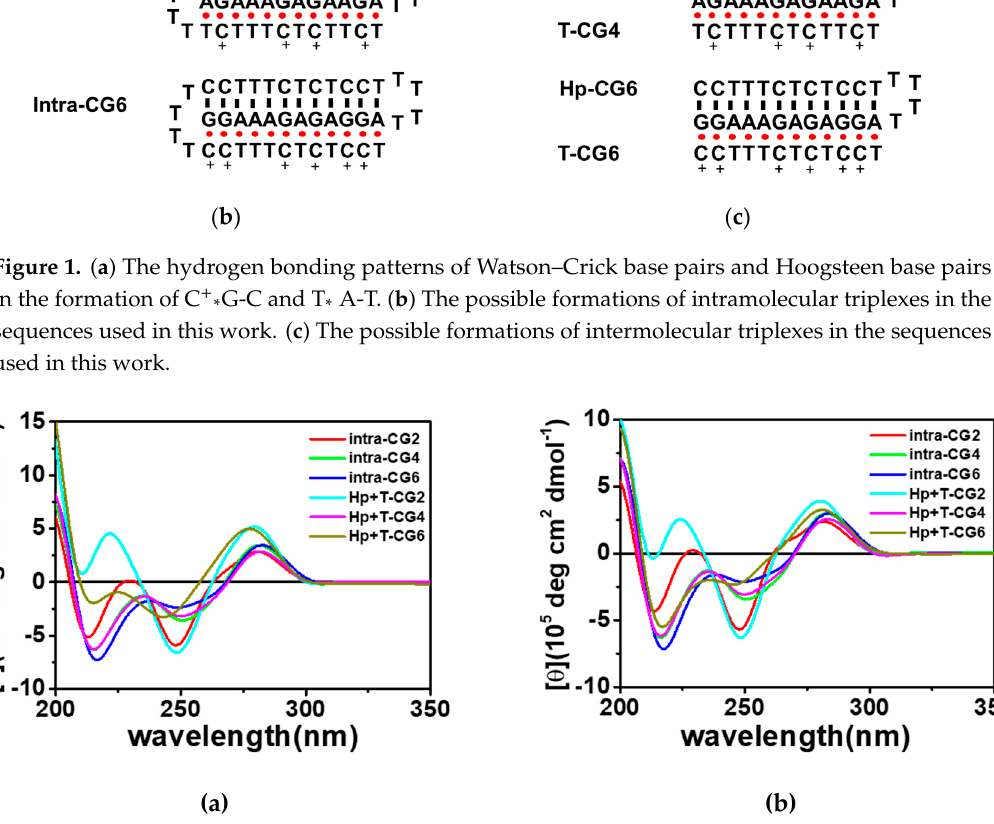
( b ) Figure 3. Normalized UV melting curves at 260 nm of ( a ) intramolecular triplexes and ( b ) intermolecular triplexes in a buffer containing 50 mM MES and 0.1 M KCl at pH 6.0 in the absence of PEG 200. 0